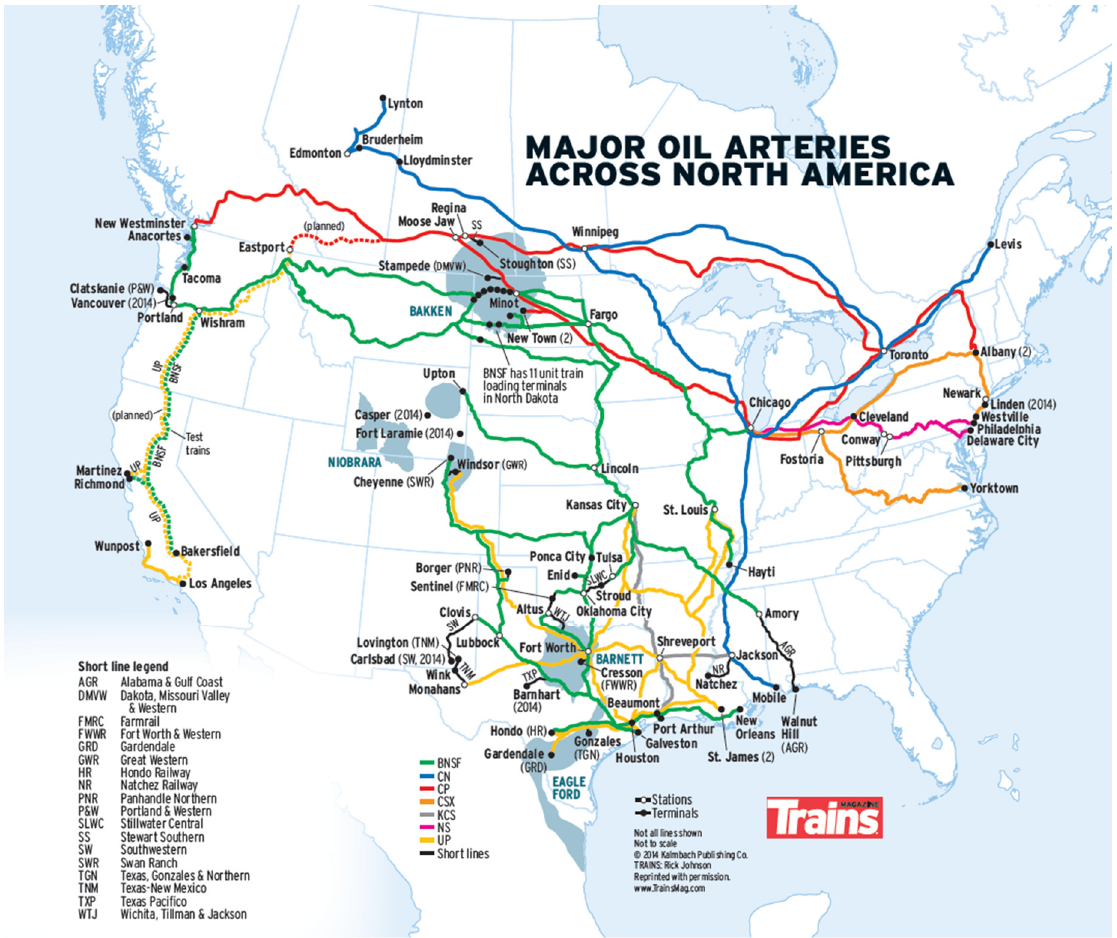
Figure 1. Major rail transportation arteries for oil across North America [4].